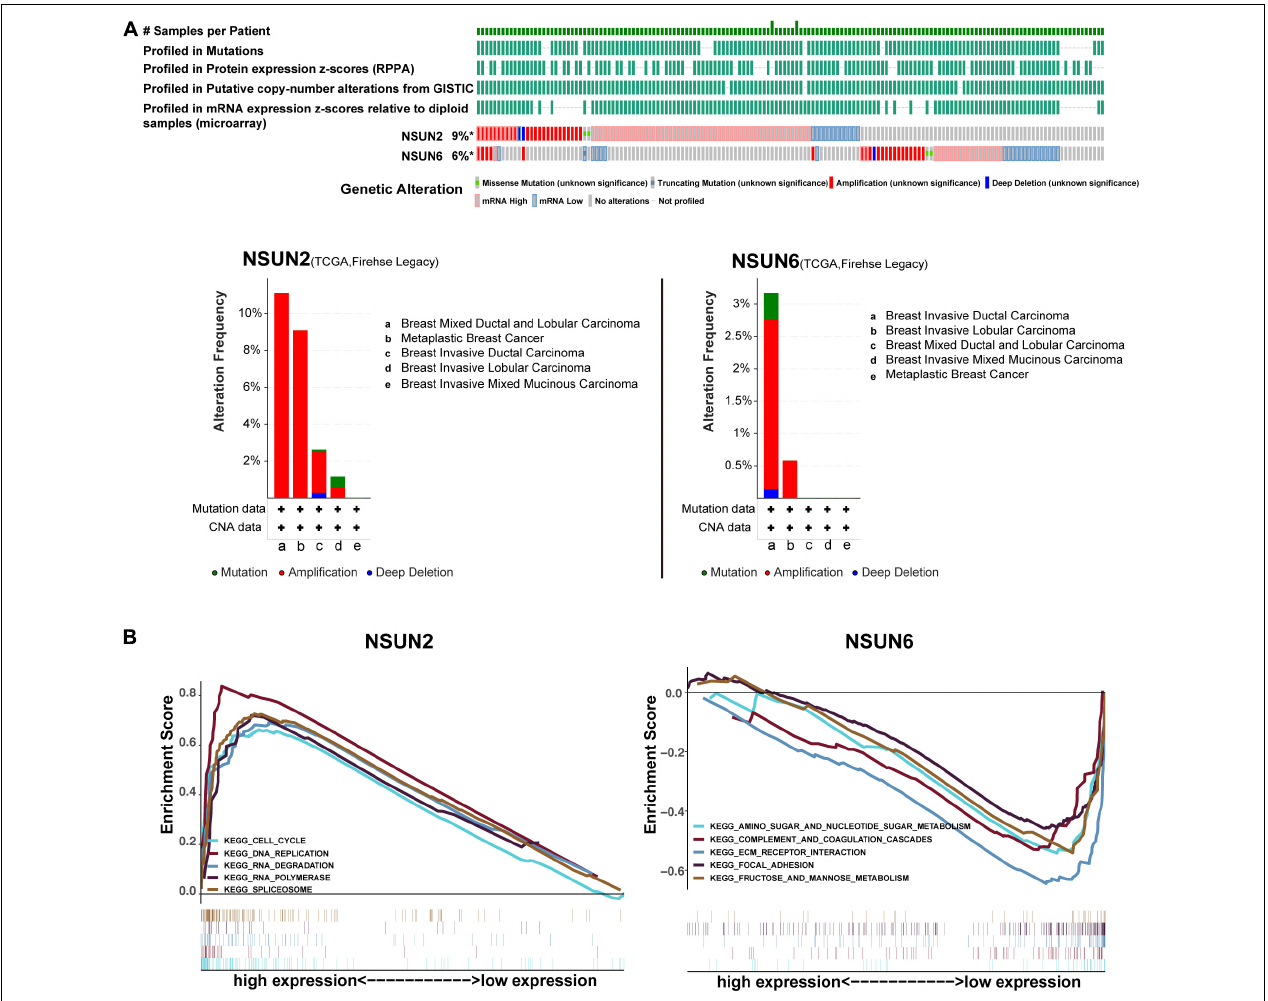
FIGURE 5 | Gene alterations analysis and gene set enrichment analysis of two prognosis-related genes. Analysis of the frequency and distribution of prognosis-related gene alteration in breast cancer based on cBioPortal data (A) . GSEA of NSUN2 and NSUN6 in TNBC samples (B) . The result is based on NES and NOM p -value. GSEA, Gene Set Enrichment Analysis; NSUN, NOP2/Sun domain family member; TNBC, triple-negative breast cancer; NES, normalized enrichment score; NOM,